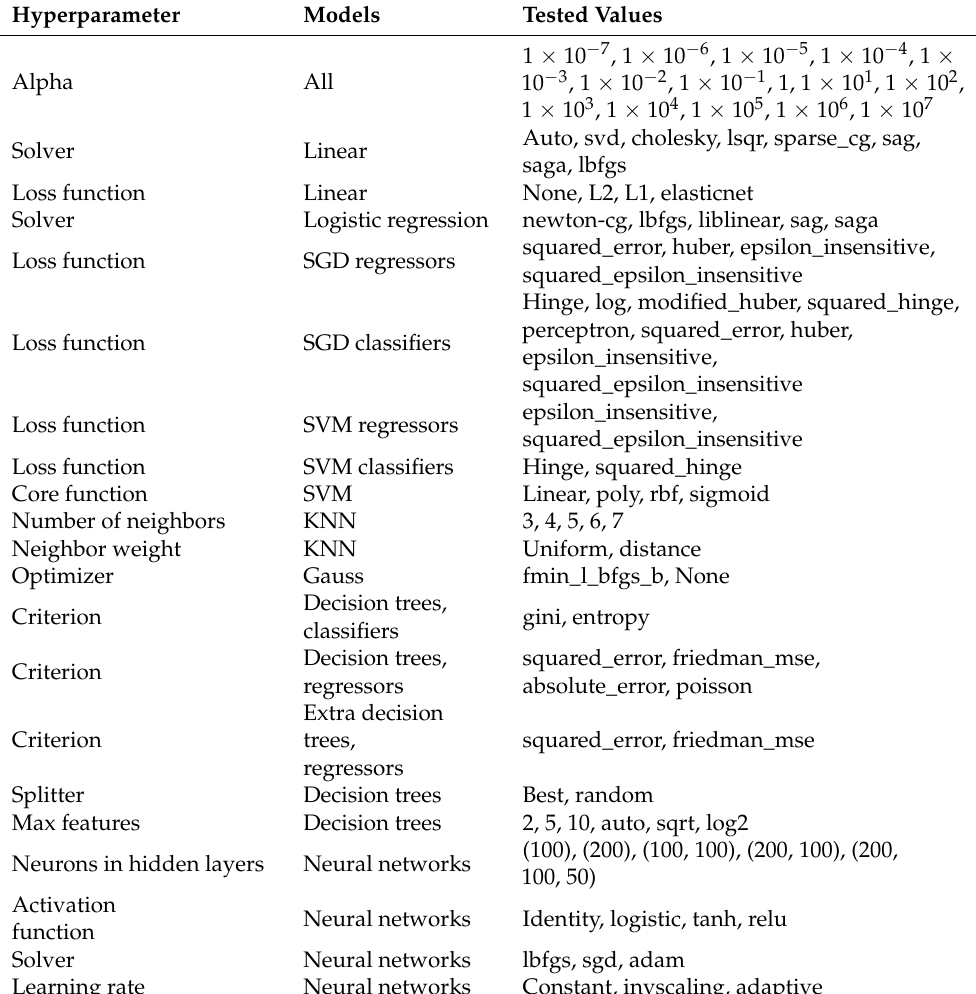
Table 3. Tested scikit-learn hyperparameter values.